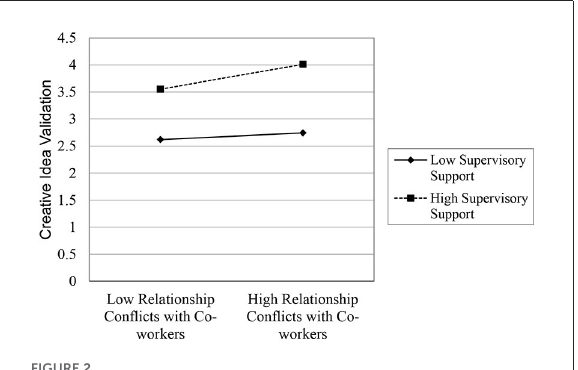
FIGURE2 Plot of interaction between relationship conflict with co-workers and supervisory support.